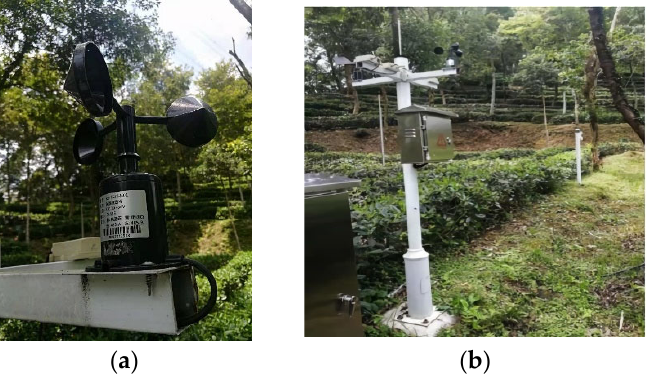
Figure 1. Environment and equipment of tea plantation. ( a ) a wind speed monitor; ( b ) a small agricultural weather station.